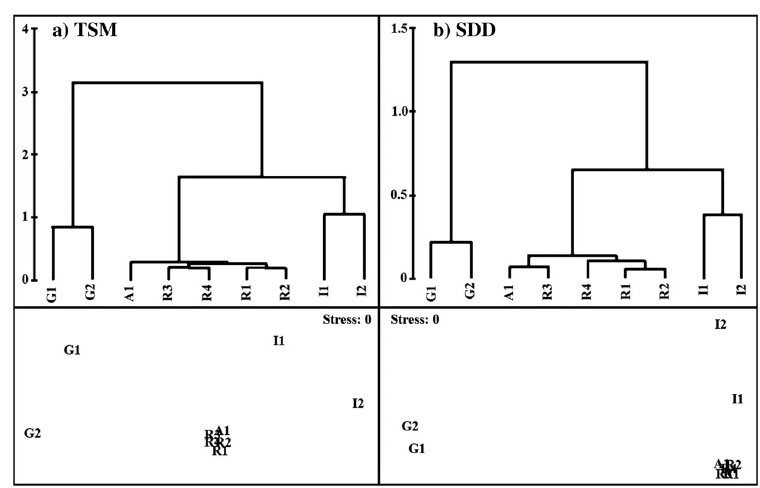
Fig. 7. Cluster and multidimensional scaling (MDS) diagrams of (a) total sus- pended matter (TSM) and (b) Secchi disk depth (SDD). Clusters show 3 main groups based on daily TSM and SDD parameter variability in all zones of Ildırı Bay. MDS plots enabled us to evaluate the similarity of the location of each group distinguished in the cluster groups. The MDS analysis clearly demon- strated 3 distinct groups of zones: I zones, G zones, and all others, i.e. R zones and the whole bay (A1 zone) (see Fig.